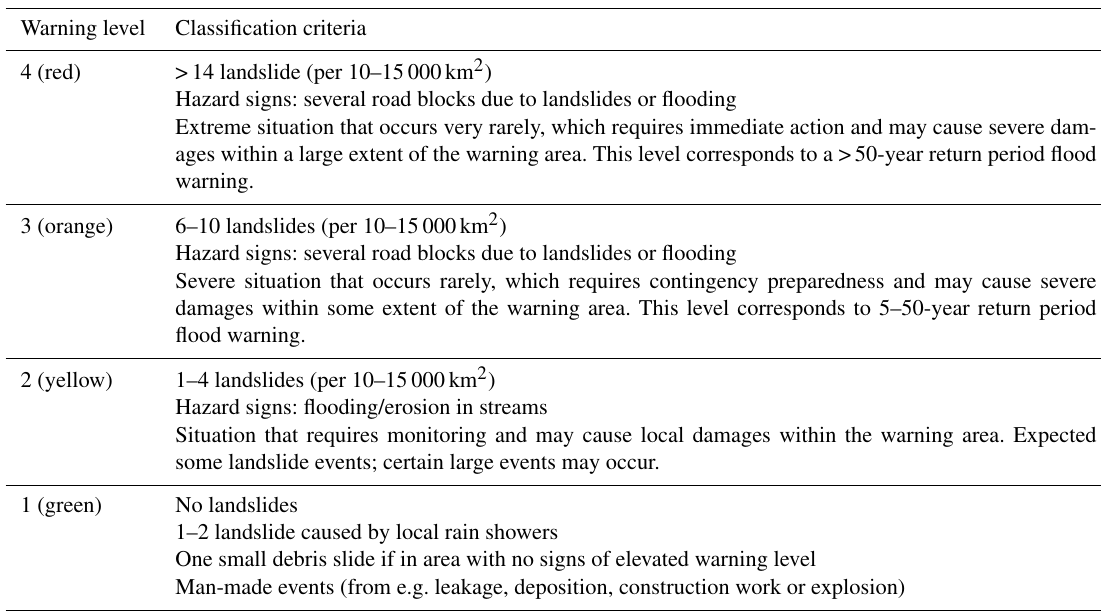
Table 1. Criteria for evaluating daily warning levels in the Norwegian